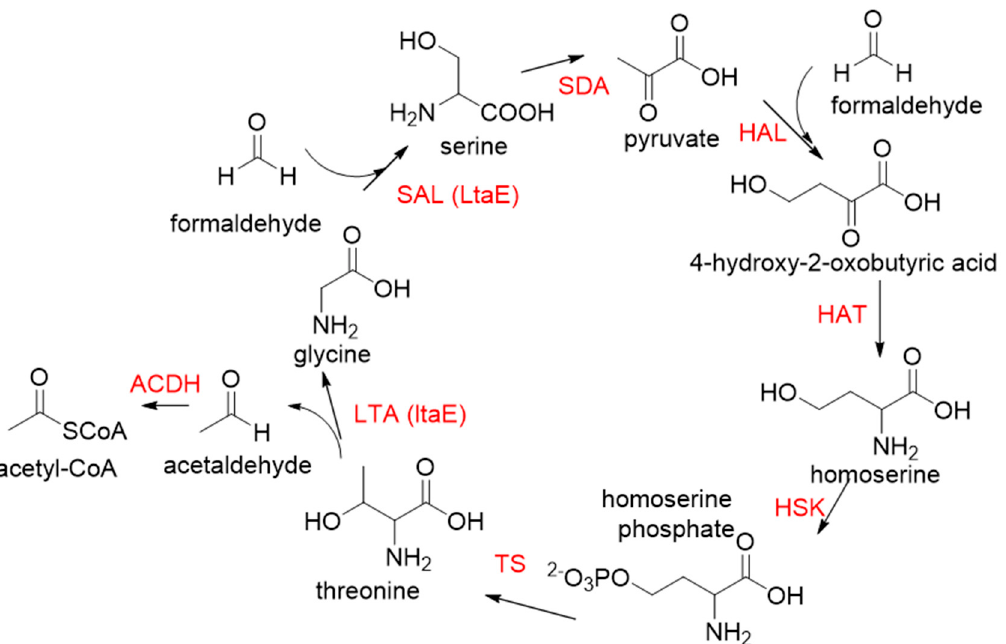
Figure 11. The homoserine cycle [74]. SAL, serine aldolase; SDA, serine deaminase; HAL, 4-hydroxy-2-oxobutanoate (HOB) aldolase; HAT, HOB aminotransferase; HSK, homoserine kinase; TS, threonine synthase; LTA, threonine aldolase; ACDH, acetylating acetaldehyde dehydrogenase. Both SAL and LTA are catalyzed by the same LtaE enzyme.